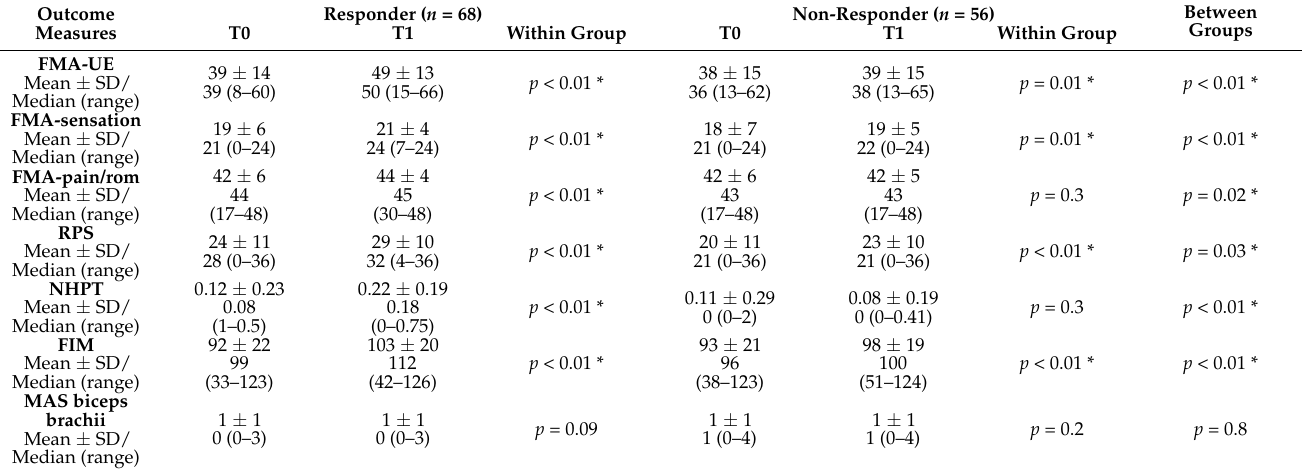
Table 4. Clinical results for the Responder and Non-Responder groups before and after